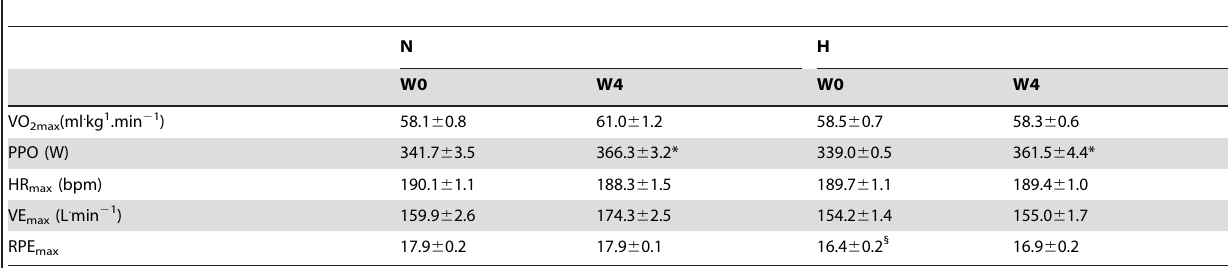
Table 4. Mean ( 6 SE) values of the incremental test to exhaustion of Normoxic (N; n =8) and Hypoxic (H; n= 10) groups.